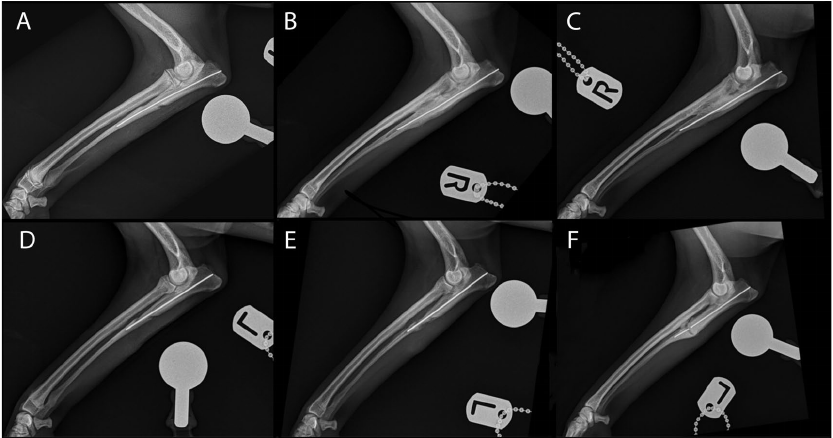
Figure 2. Medio-lateral view of the right and left antebrachium immediately after surgery ( A , D ), at the 5-week follow-up appointment ( B , E ) and at the 8-month follow-up appointment ( C , F ). Postoperative analgesia was provided by the administration of methadone (0.2 mg/kg intramuscular, every 4 h) (Comfortan, Dechra, Shrewsbury, UK) whilst in the hospital and meloxicam (0.1 mg/kg SID orally) (Loxicom, Norbrook, Corby, UK) for two weeks. Cage rest and lead-only walk for 10 weeks were instructed at